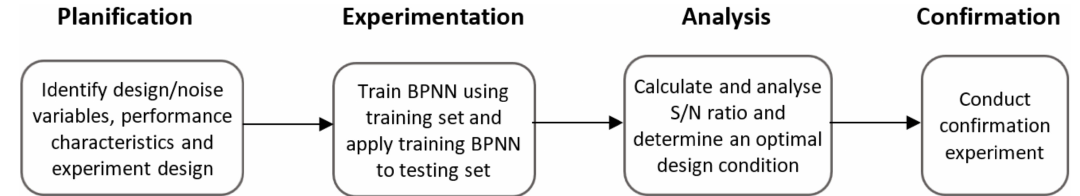
Figure 4. Scatter matrix of the position dataset: ( a ) before applying the reduction filter; ( b ) after applying the data reduction filter.